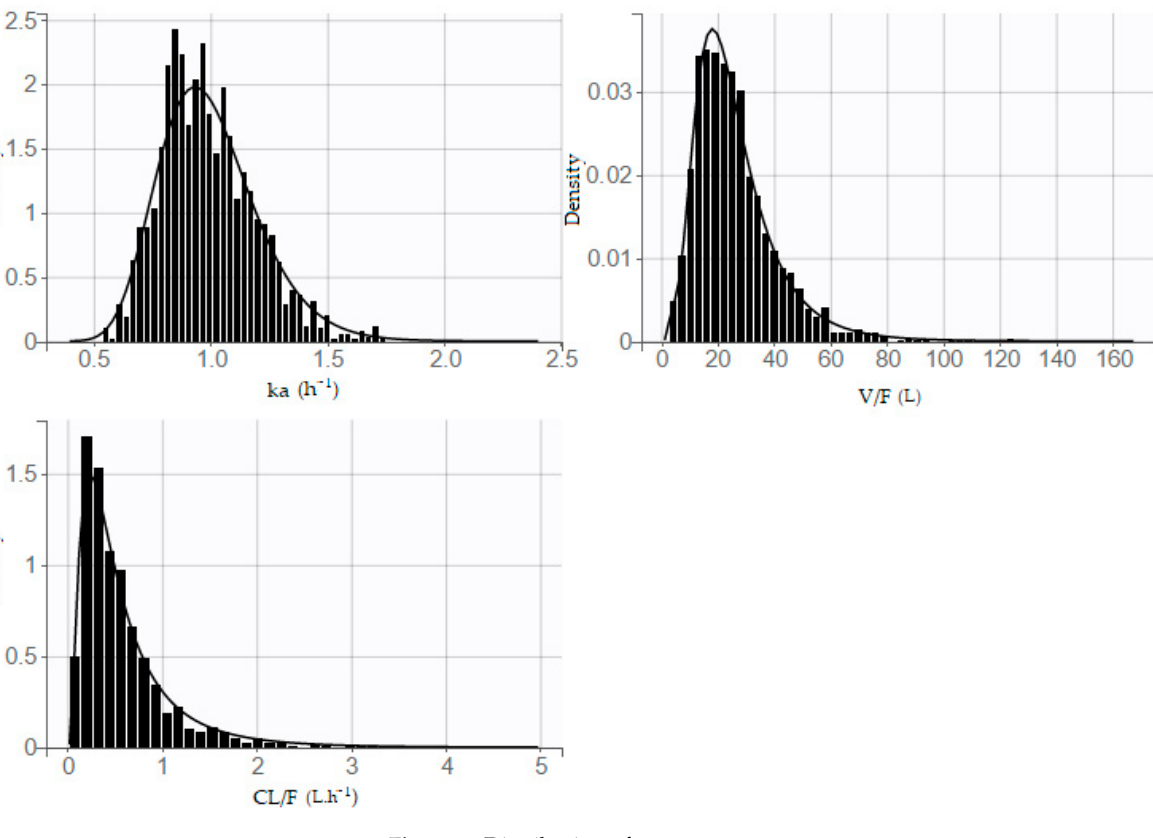
Figure 4. Distribution of parameters.